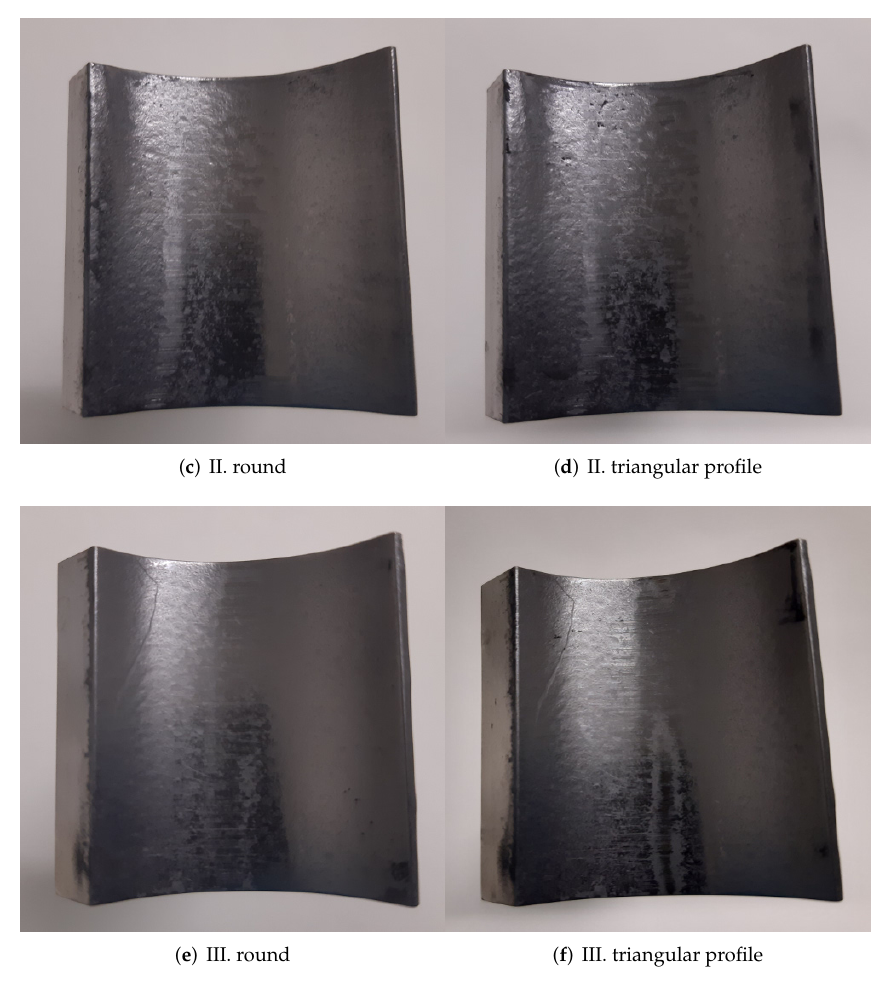
Figure 8. The top foils after the measuring series of both sleeve types (round/cleaned, triangu- lar